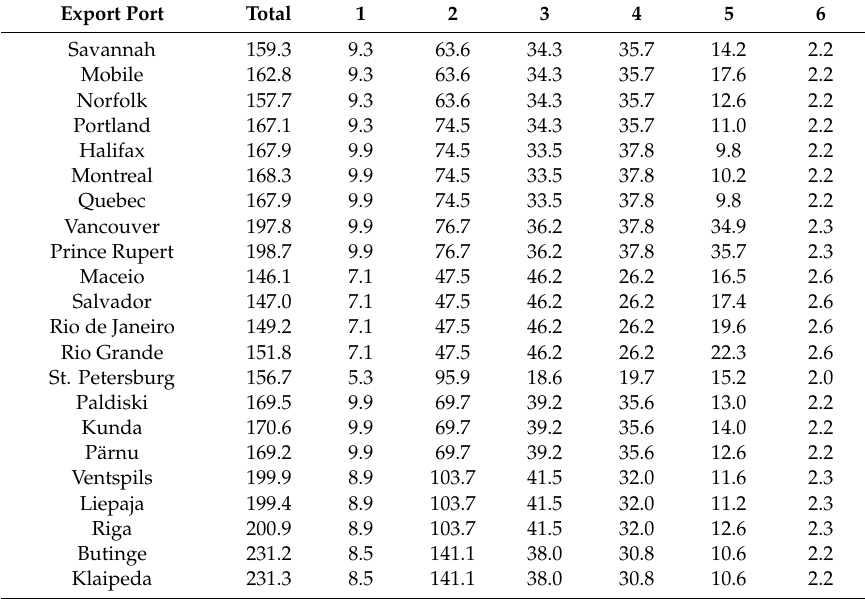
Table A11. Overview of supply chain costs of torrefied pellets produced from roundwood, transported over 500 km to export ports and including 50 km feedstock transport, in € / t pellets. Components included in the table: 1. Feedstock transport; 2. Feedstock; 3. Pelletizing; 4. Pellet transport; 5. Shipping; 6. Port